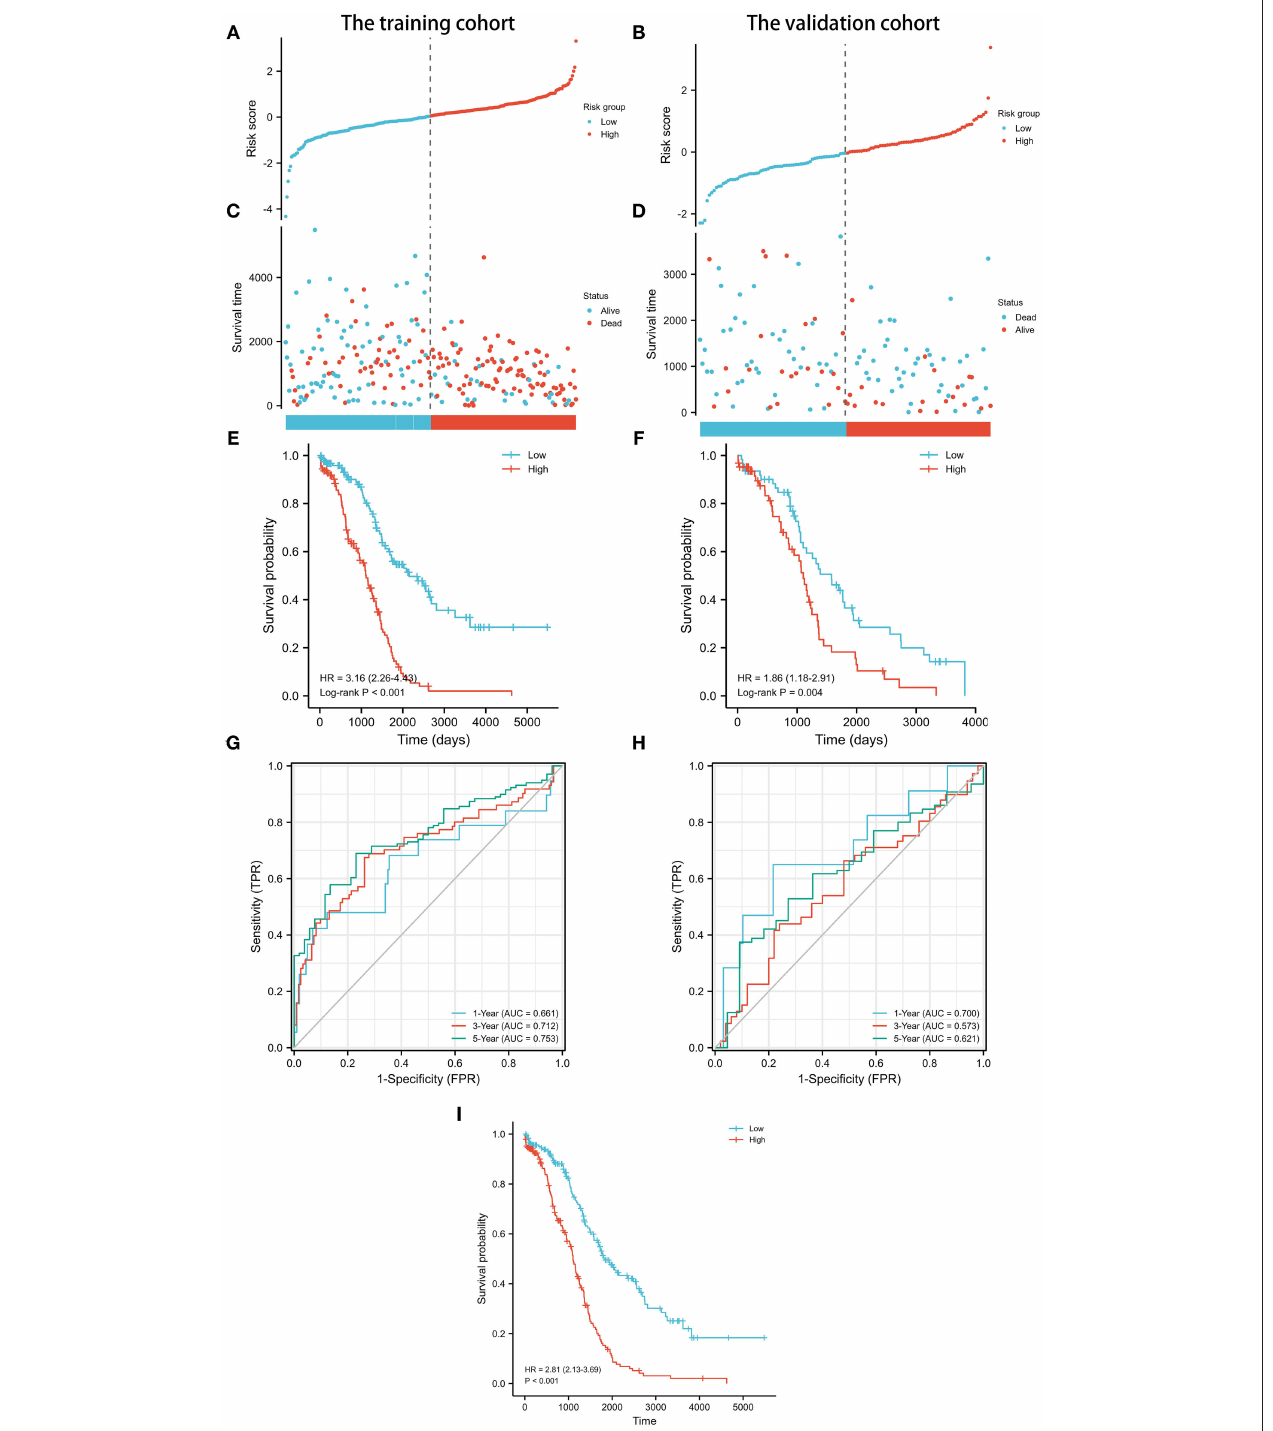
FIGURE 3 | Prognostic analysis of pyroptosis-related lncRNA signature in the training and validation cohorts. (A) Distribution of risk scores in the training cohort. (B) Distribution of risk scores in the validation cohort. (C) Distributions of overall survival status, overall survival, and risk score in the training cohort. (D) Distributions of overall survival status, overall survival, and risk score in the validation cohort. (E) Kaplan-Meier curves for the overall survival of patients in the high- and low-risk groups in the training cohort. (F) Kaplan-Meier curves for the overall survival of patients in the high- and low-risk groups in the validation cohort. (G) AUC of time-dependent ROC curves verified the prognostic accuracy of the risk score in the training cohort. (H) AUC of time-dependent ROC curves verified the prognostic accuracy of the risk score in the validation cohort. (I) Kaplan-Meier curves for the overall survival of patients in the high- and low-risk groups in the whole cohort.